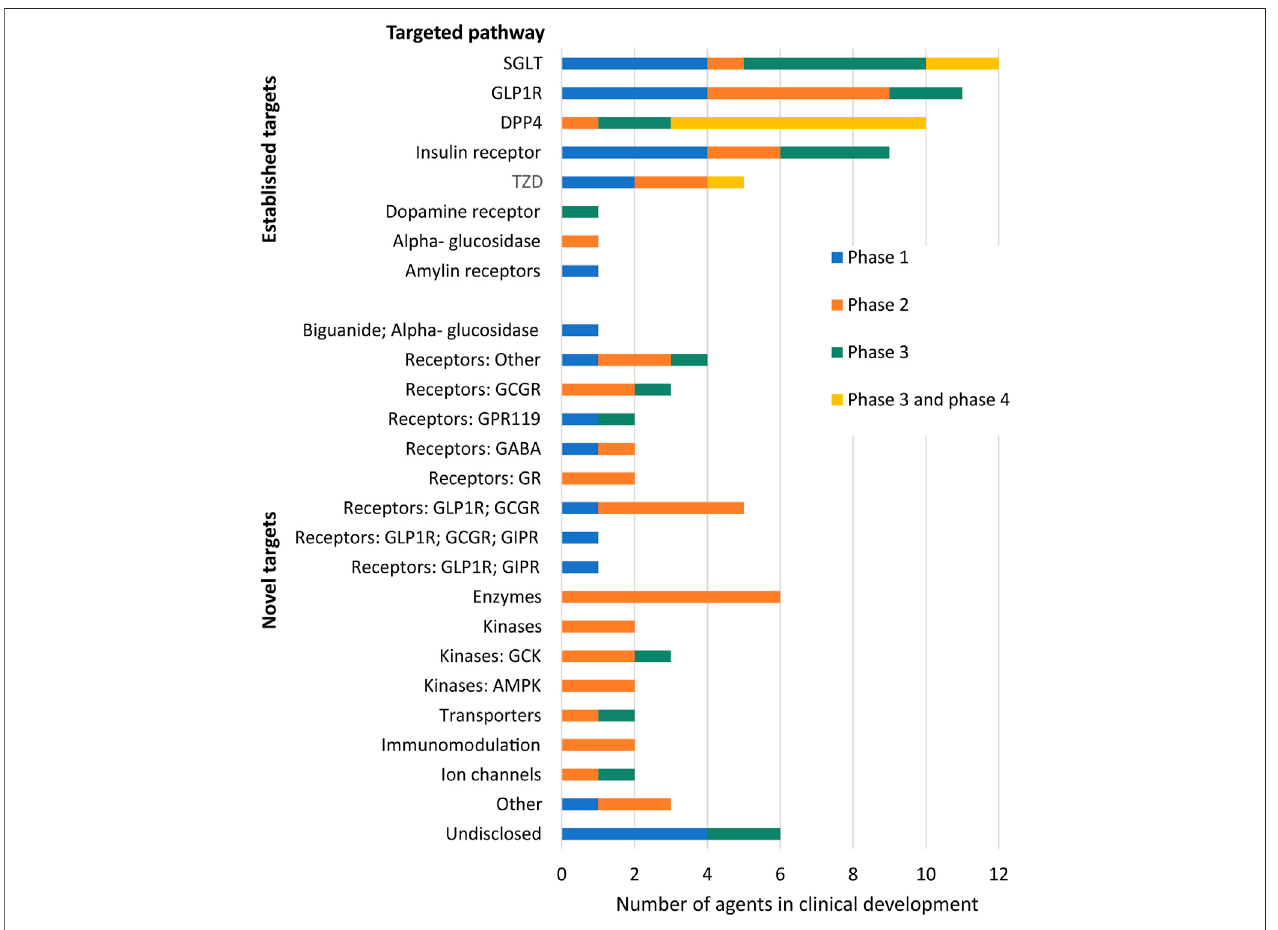
FIGURE4| Themoleculartargetsofthe99anti-diabeticagentsinclinicaltrials.Thephasestatusisthehighestclinicalphaseeachagenthasachieved.Asurprising numberclinicalagents – nearlyhalf – targetnovelmoleculartargetsorcombinationregimens.Noveltargetsorpathwaysarethosethathavenotyetbeenvalidatedthrough approvalofanFDA-approveddrugfortreatmentofdiabetes.Approximatelyhalfoftheagentstargetalreadyestablishedpathways,i.e.,moleculartargetsthathavebeen validated through the FDA-approval of an agent targeting that pathway for the treatment of diabetes. Six of the agents had an undisclosed mechanism of action. DPP4,Dipeptidylpeptidase4;GLP-1R,Glucagon-likepeptide-1(GLP-1)receptor;SGLT2,Sodium-glucoseco-transporter-2;TZD,Thiazolinediones;GCGR,Glucagon receptor; GPR119, Glucose-dependent insulinotropic receptor (G-Protein coupled receptor 119); GR, Glucocorticoid receptor; GIPR, Gastric Inhibitory Polypeptide Receptor; GCK, glucokinase; AMPK, 5 ′ -AMP-activated protein kinase.